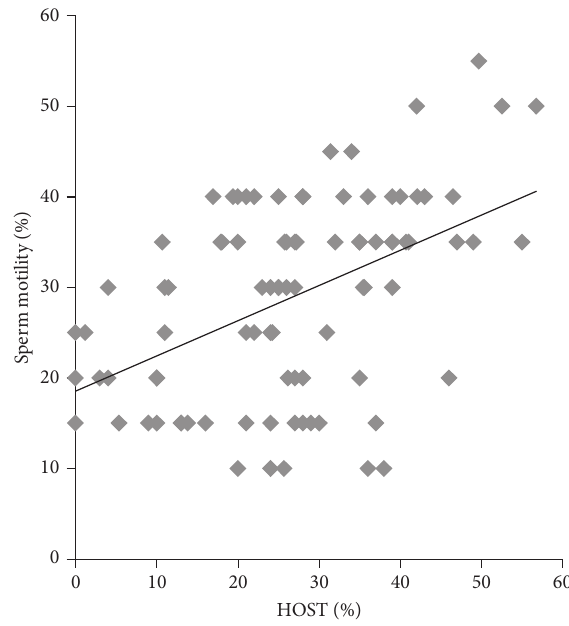
Figure 1: Dispersion graphic between sperm motility and HOST ( 𝑅 2 = 0.22